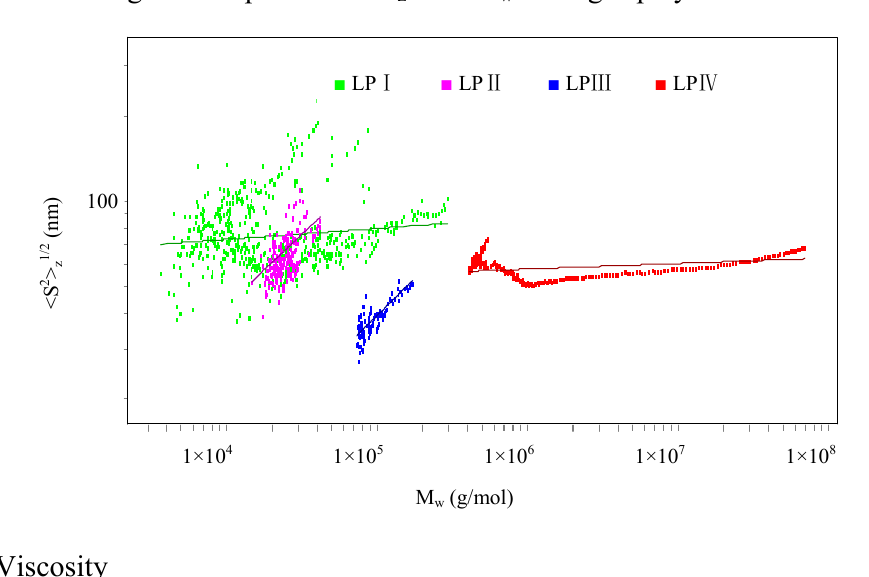
Figure 2. The double logarithmic plots of <S 2 > z1/2 vs. M